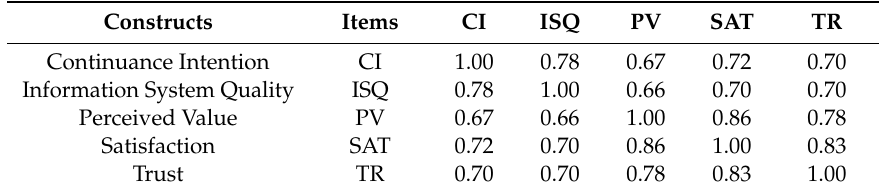
Table 5. Latent variable